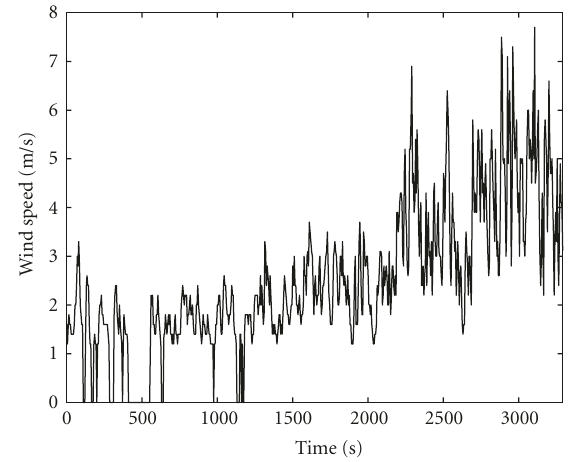
Figure 2: Measured wind speed for the corresponding signal fading shown in Figure 1. The wind speed was measured every 5